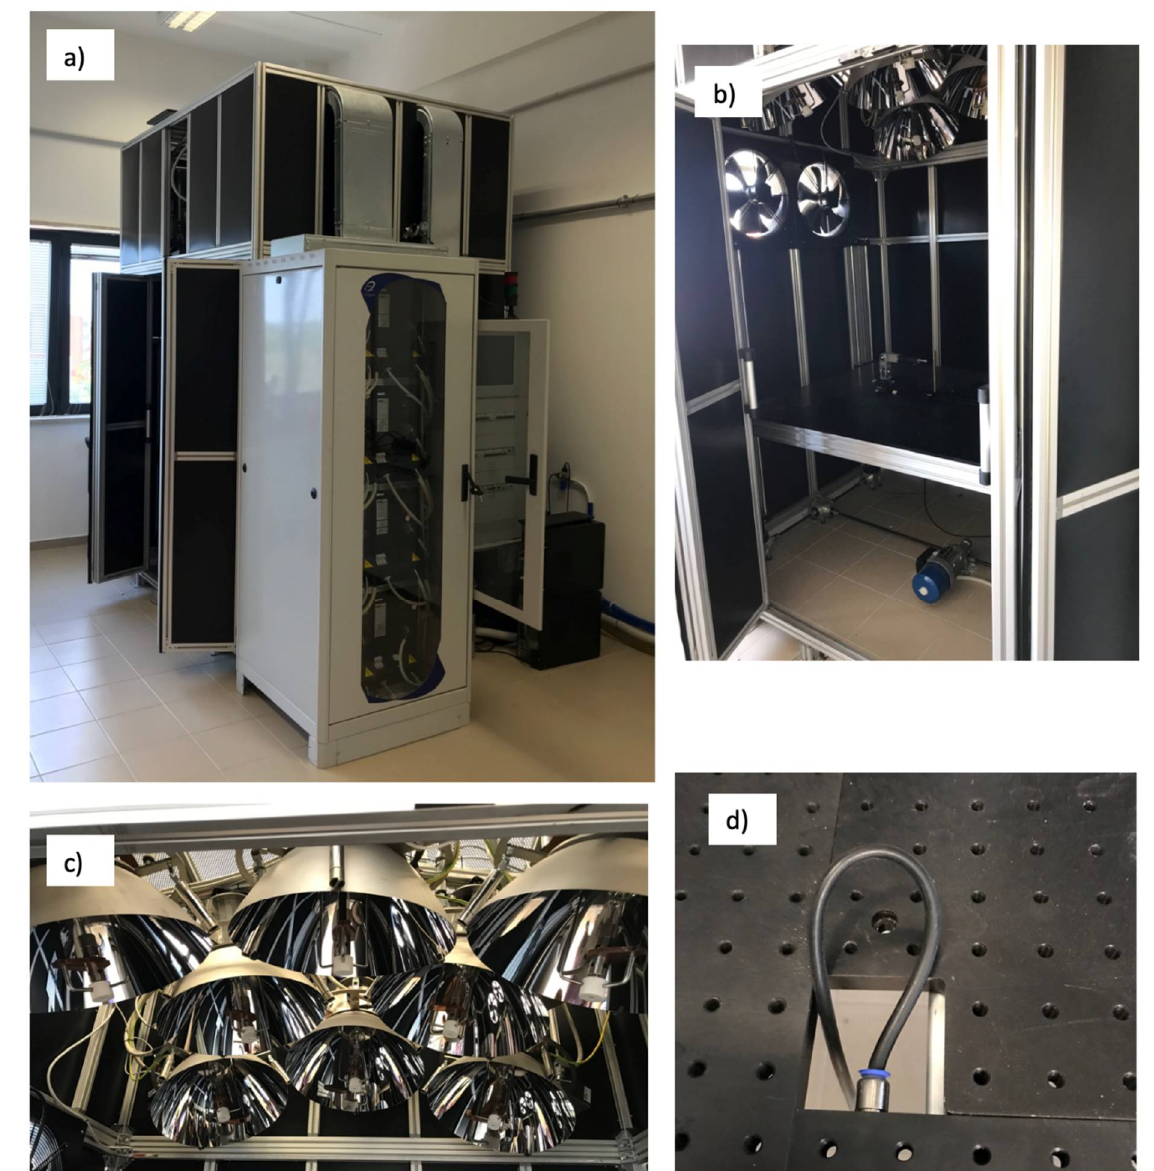
Figure 10. Pictures of the HFSS: ( a ) overall view; ( b ) inside view; ( c ) detail of the lamps; ( d ) detail of the chilled mobile optical bench.